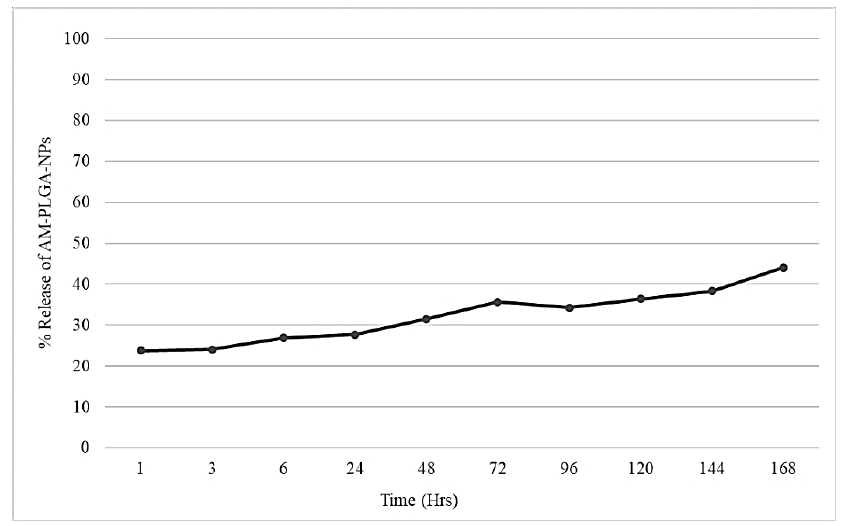
Figure 2. In vitro release profile of the AM-PLGA-NPs during 168 h period (7 days).